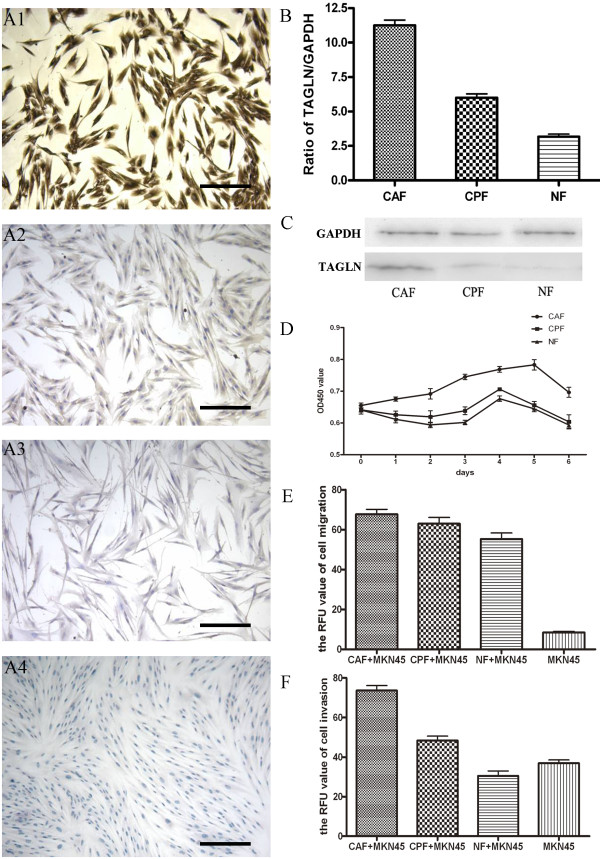
The expression of TAGLN is upregulated in gastric cancer-associated fibroblasts. A: characterization of gastric fibroblasts (ICC). a1: vimentin, positive. a2: α-SMA, positive. a3: fibronectin, positive. a4: cytokeratin, negative. Original magnifications: ×200. Scale bars, 100 μm. B: QRT-PCR analysis of TAGLN in CAF, CPF and NF. *, P < 0.05, **, P < 0.01, compared to NF. C: Western blot analysis of TAGLN in CAF, CPF and NF, TAGLN expression level was decreased successively. D: fibroblasts growth curve were determined by CCK-8 assay, CAFs grew quickier than the others. E: CAF had higher ability to enhance MKN-45’s migration ability than CPF and NF, ***, P < 0.001 compared to MKN-45. F: CAF had higher ability to enhance MKN-45’s invasion ability than CPF and NF, *, P < 0.05, **, P < 0.01, compared to MKN-45.